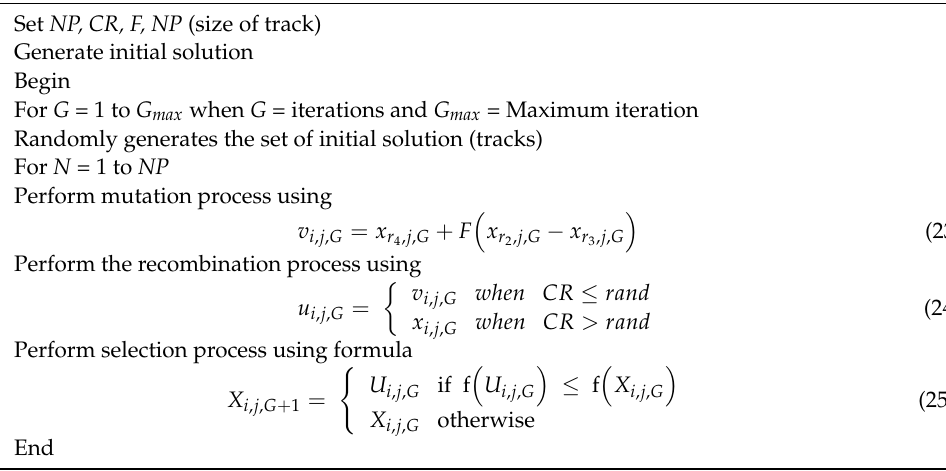
Algorithm 7. Differential evolution (DE)